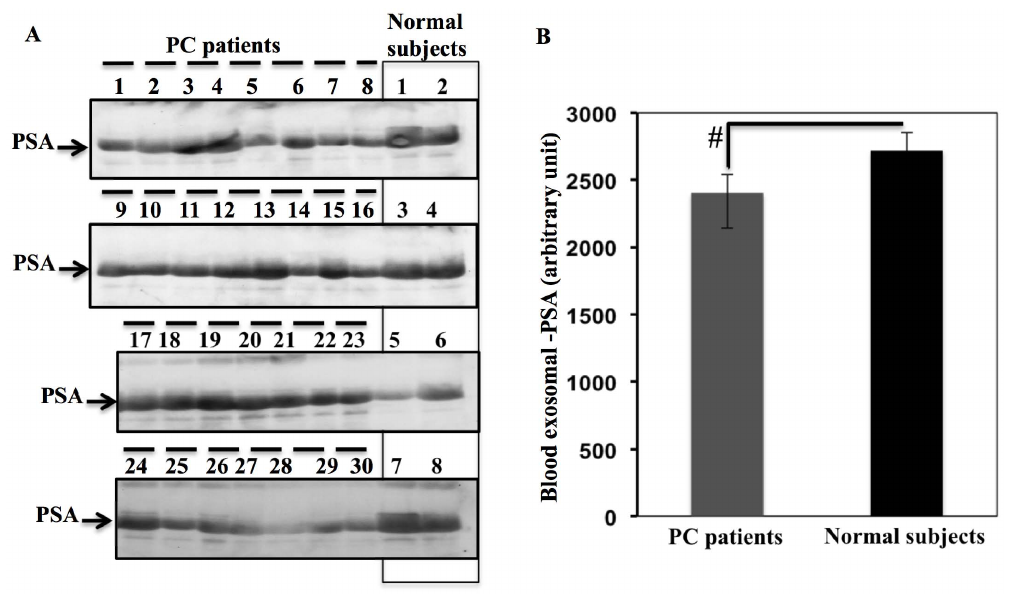
Figure 8. PSA is detected in exosomes derived from the plasma of PC patients and normal subjects. A. Exosomes were collected from the plasma of 30 pre-prostatectomy PC patients and 8 normal subjects. Exosomes were subjected to standard immunoblotting analysis for the status of PSA. As shown in the figure, all PC patients and healthy subjects were positive for exosomal PSA. B. Optical densities of PSA bands (A) were assessed using Quantity-1 software. Exosomal-PSA expression was calculated as the average 6 SEM, and the differences between the two groups were found to be non-significant.